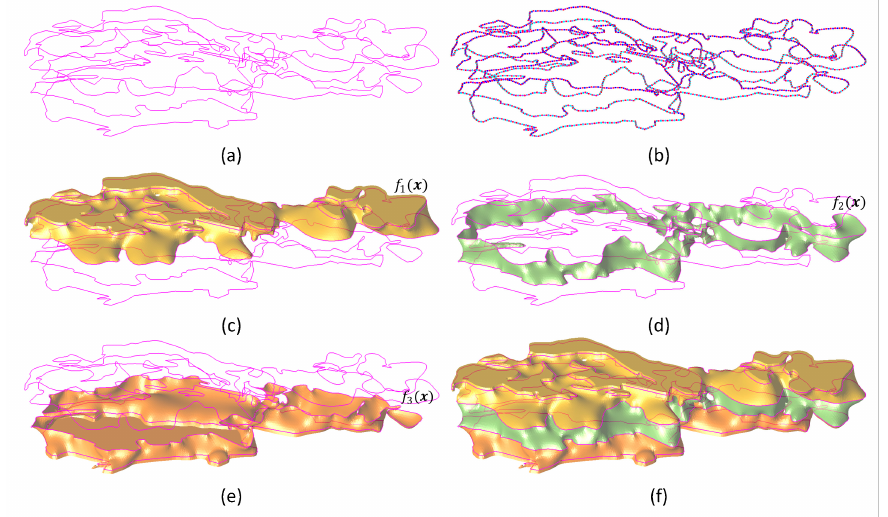
Figure 4. Combination constraint of the block modeling at different stages: ( a ) the interpreted contours; ( b ) the interpolation constraints sampled from the contours; ( c–e ) are the modeling results at different stages; ( f ) the combined